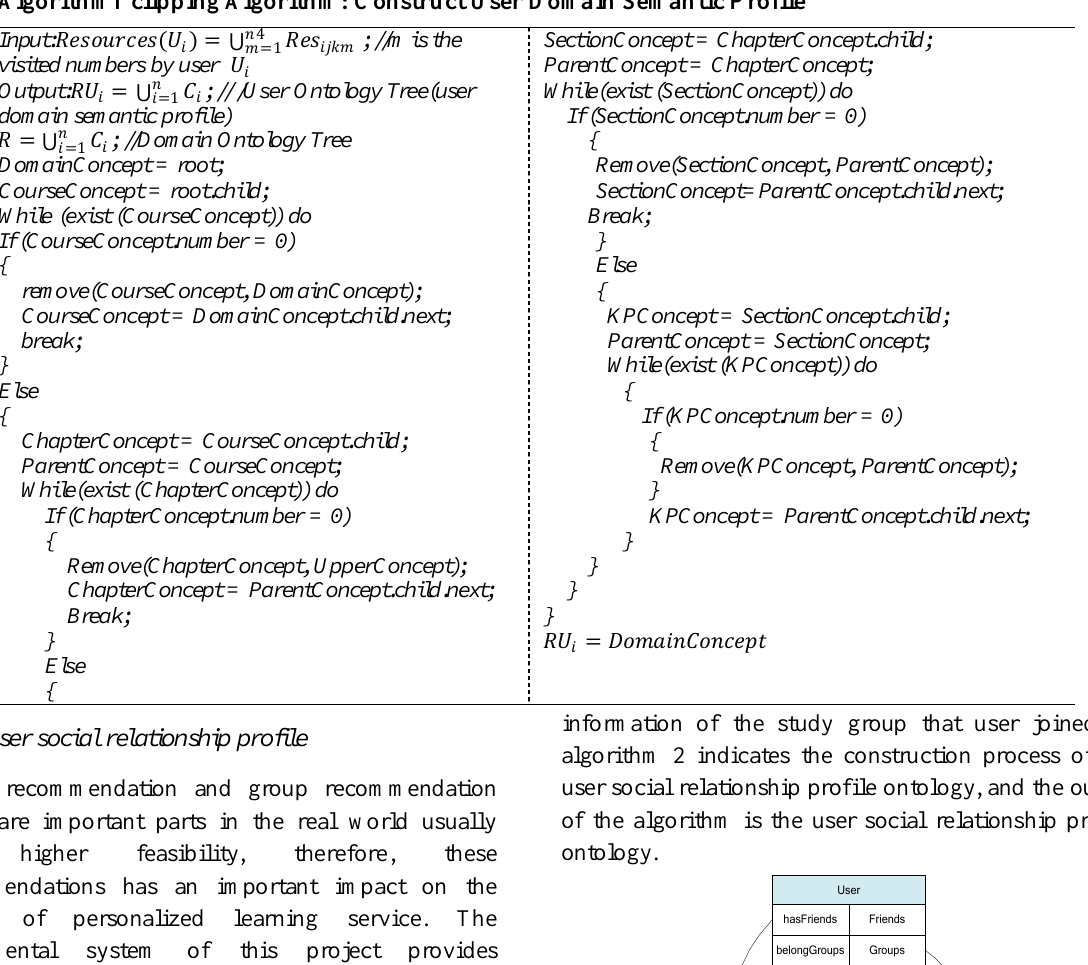
Algorithm1 clipping Algorithm: Construct User Domain Semantic Profile